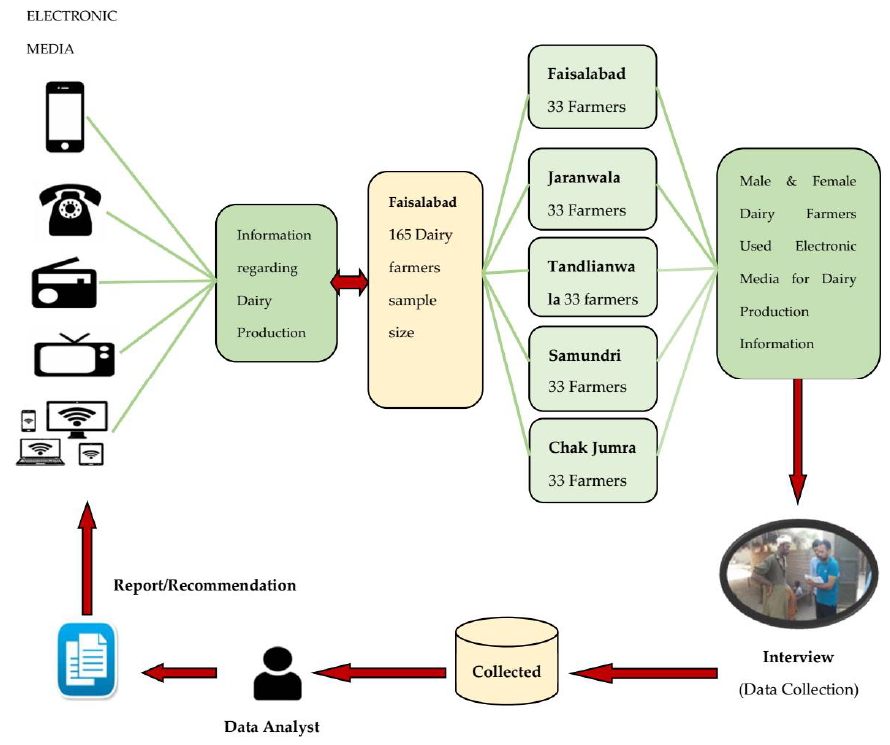
Figure 1. Conceptual framework used for the research study.